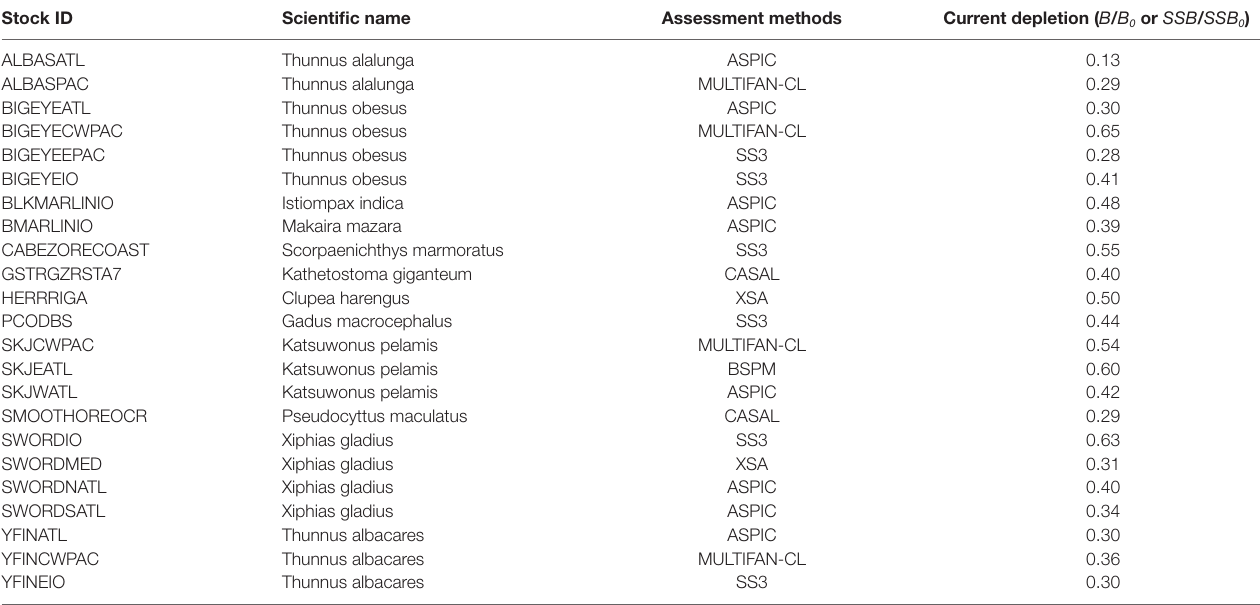
TABLE 1 | The selected 23 fish stocks assessed by formal fisheries stock assessment methodologies from RLSADB v4.495. Stock